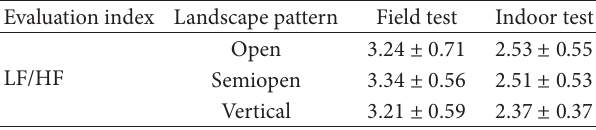
Table 8: Descriptive analysis of the evaluation indices in each